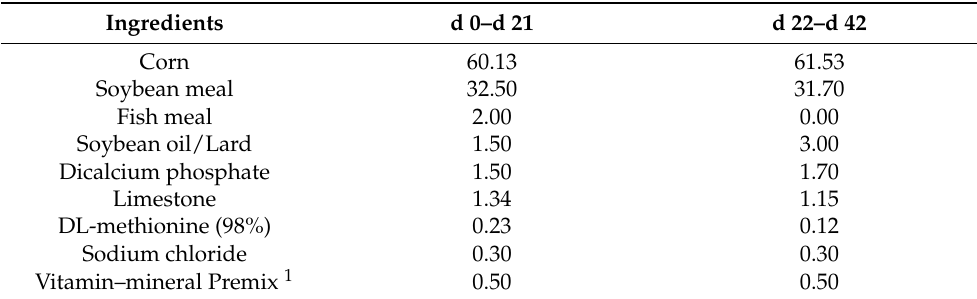
Table 1. The levels of ingredients of basal diets (%).